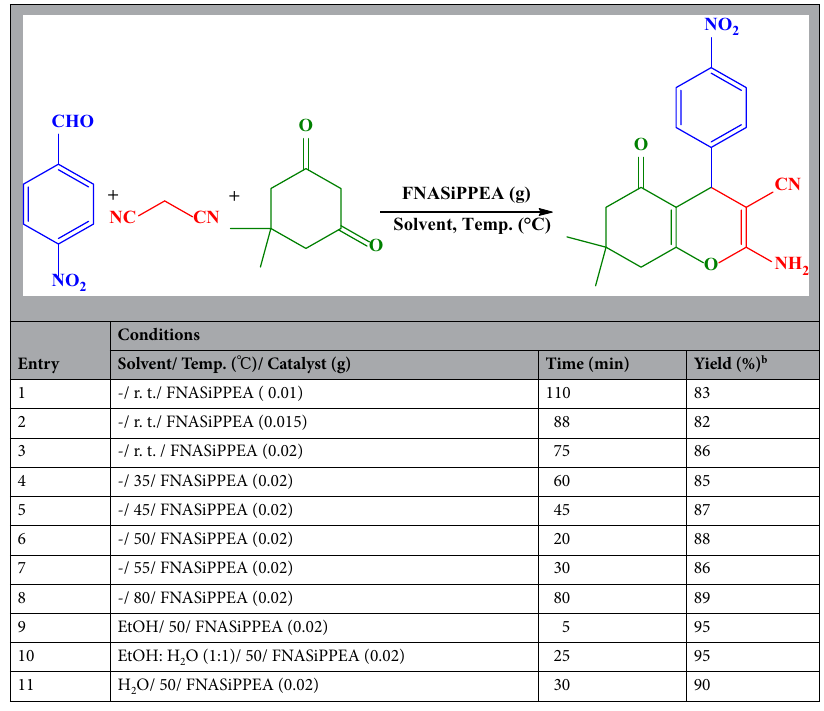
Table 4. Optimization of the reaction conditions for the synthesis of THBP. a a conditions: 4-nitrobenzaldehyde (1 mmol), dimedone (1 mmol), malononitrile (1.5 mmol), Solvent (10 ml). b Isolated Yield.